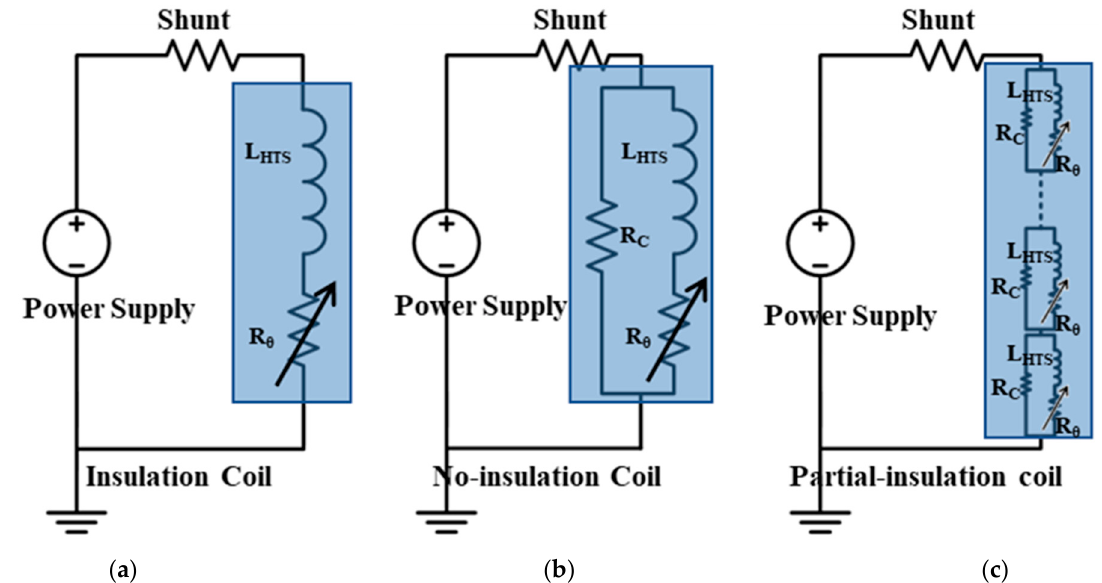
Figure 2. Simplified equivalent circuit diagram of HTS coils: ( a ) insulation HTS coil, ( b ) no-insulation HTS coil, ( c ) partial-insulation coil.